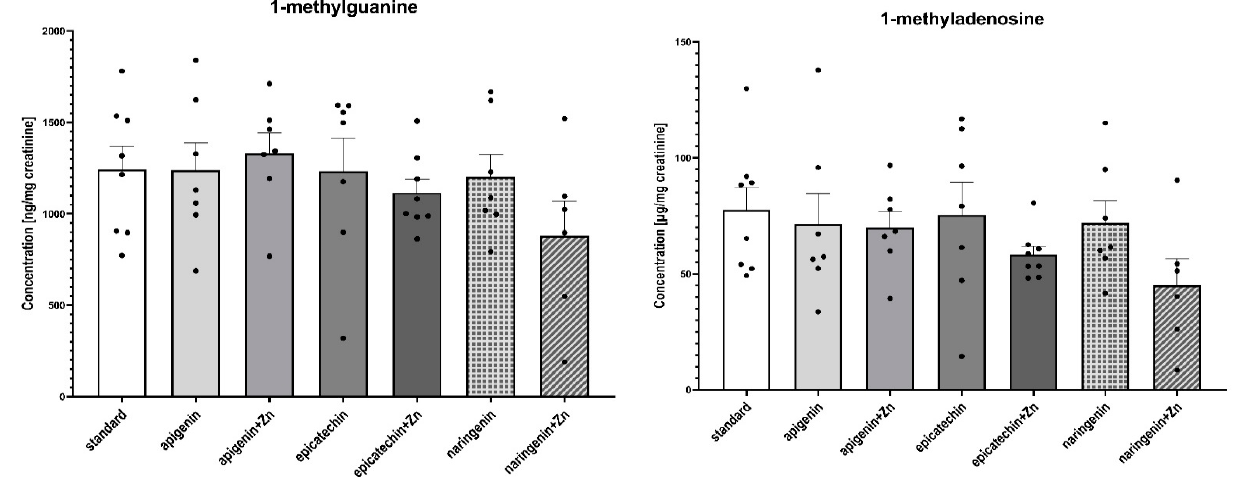
Figure 4. The content of selected methyl derivatives in urine of rats treated with 7,12-dimethylbenz[a]anthracene in relation to supplementation. The differences were considered significant at: *— p < 0.05; **— p < 0.01; ***— p < 0.001; ****— p < 0.0001. Table 2. The results of significance differences among means of experimental groups.